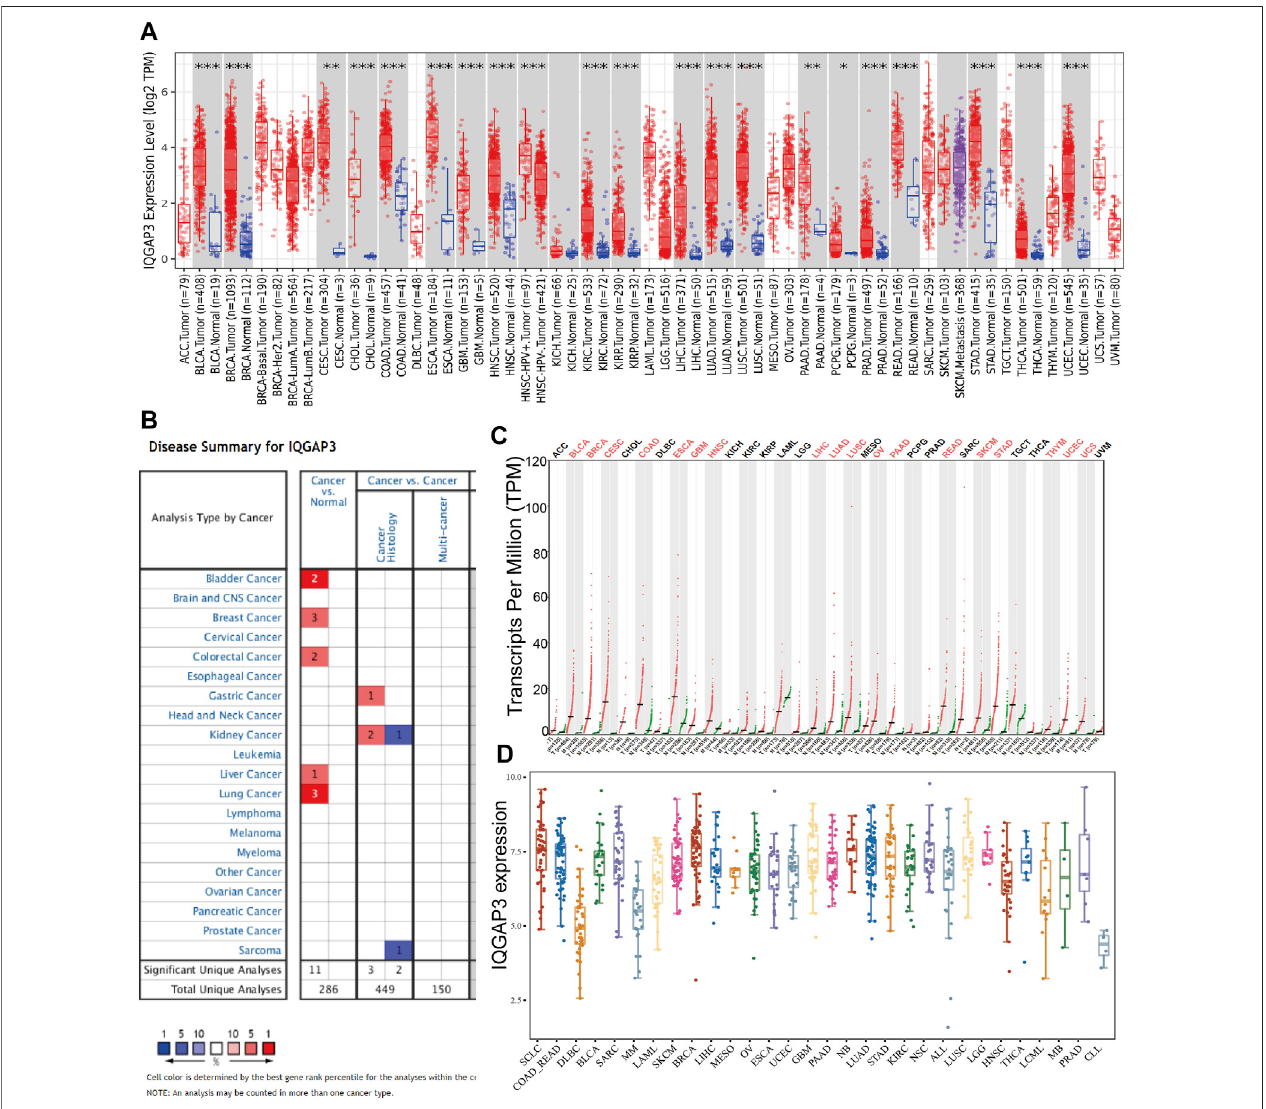
FIGURE1| ExpressionanalysisforIQGAP3inhumancancers. (A) TheexpressionofIQGAP3inpan-canceranalysisbytheTIMERdatabase. (B) Theexpressionof IQGAP3 in pan-cancer analysis by using the oncomine database. (C) The expression of IQGAP3 in pan-cancer analysis by using the GEPIA database. (D) The expression of IQGAP3 in pan-cancer cells lines analysis by using the CCLE database.